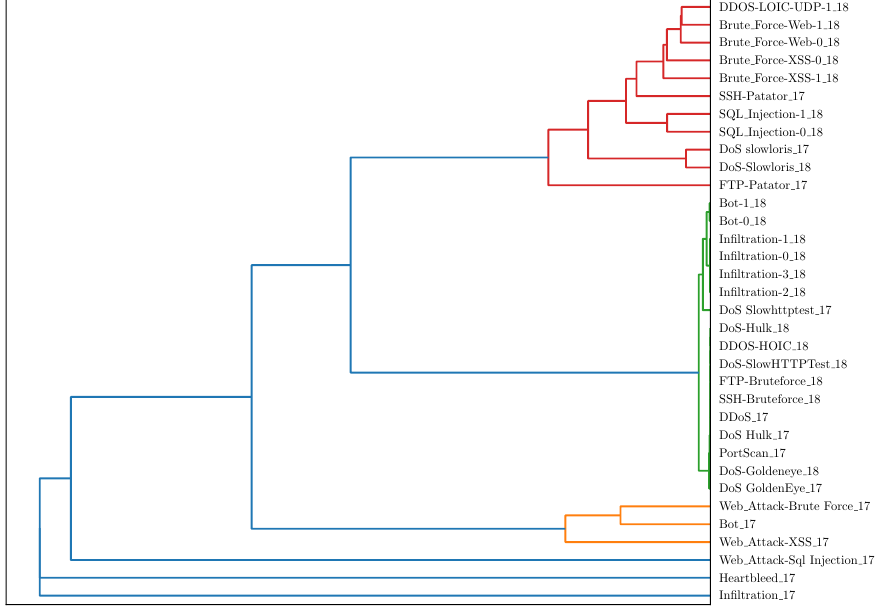
Figure 14. Hierarchical clustering of similarities between CICIDS2017 and CSE-CIC-IDS2018 attack scenarios based on sig temp